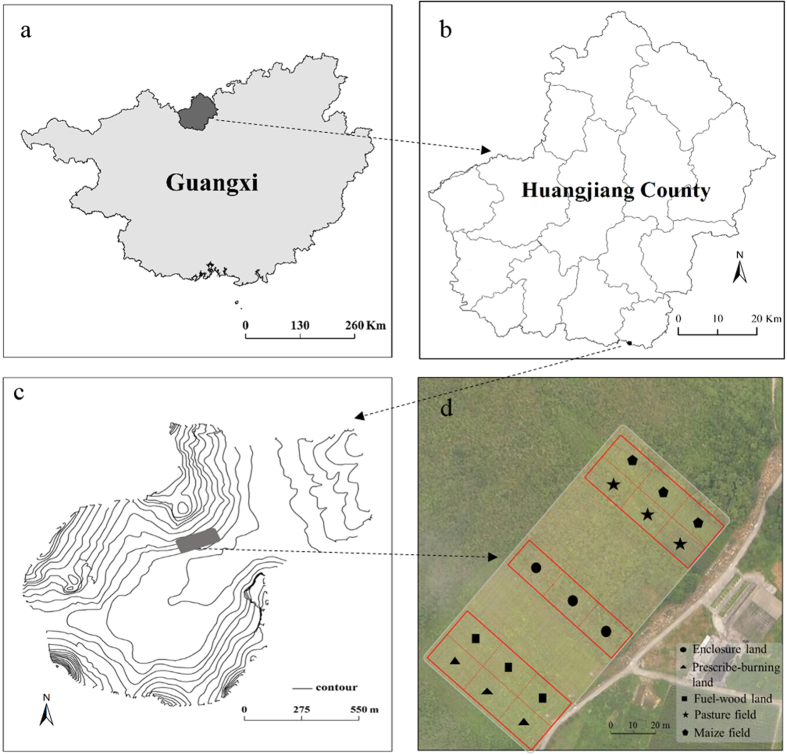
Map of region and field area.(a) Location map of Huanjiang County within the Guangxi Province, China. (b) Location map of the studied catchment within the Huangjiang County. (c) Location of long-term observation field. (d) The layout of sampled land use plots. (a–c maps were created by ArcGIS 9.3 URL: http://www.esrichina.com.cn/softwareproduct/ArcGIS/; (d) photo were taken by Wei Luo & Xianli Xu using aerial instrument DJI Phantom 3 URL: http://www.dji.com/cn/products/phantom-3. Here we appreciate their supply).